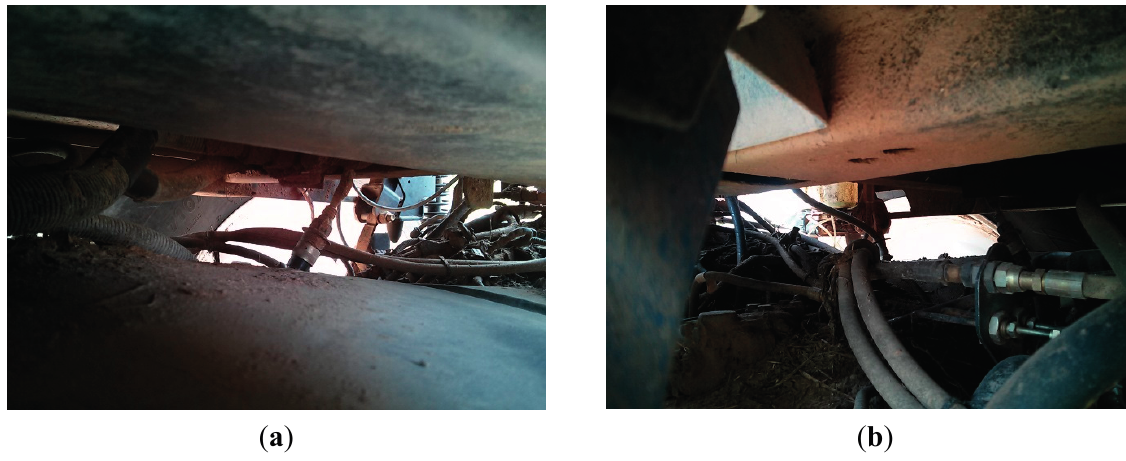
Figure 9. Photos of the space under the cab of the New Holland TM190 tractor tested